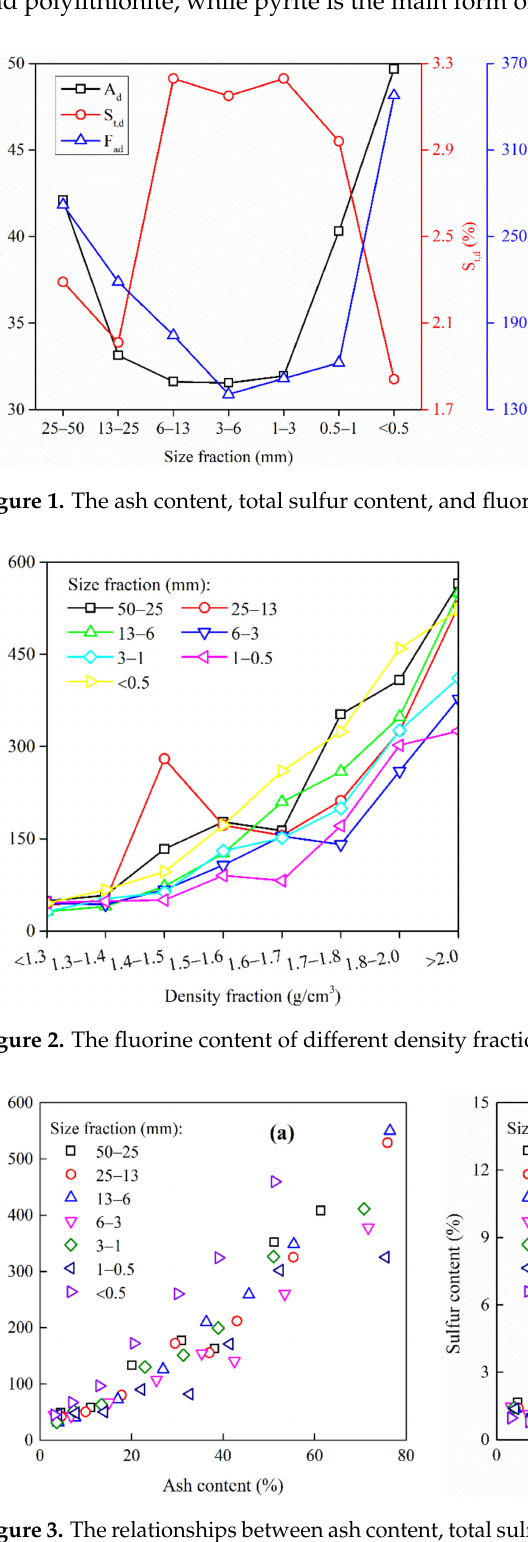
Figure 3. The relationships between ash content, total sulfur content, and fluorine content for different size fractions. ( a ) ash content vs. fluorine content; ( b ) ash content vs. total sulfur content. The high ash content corresponds to the fraction with a high